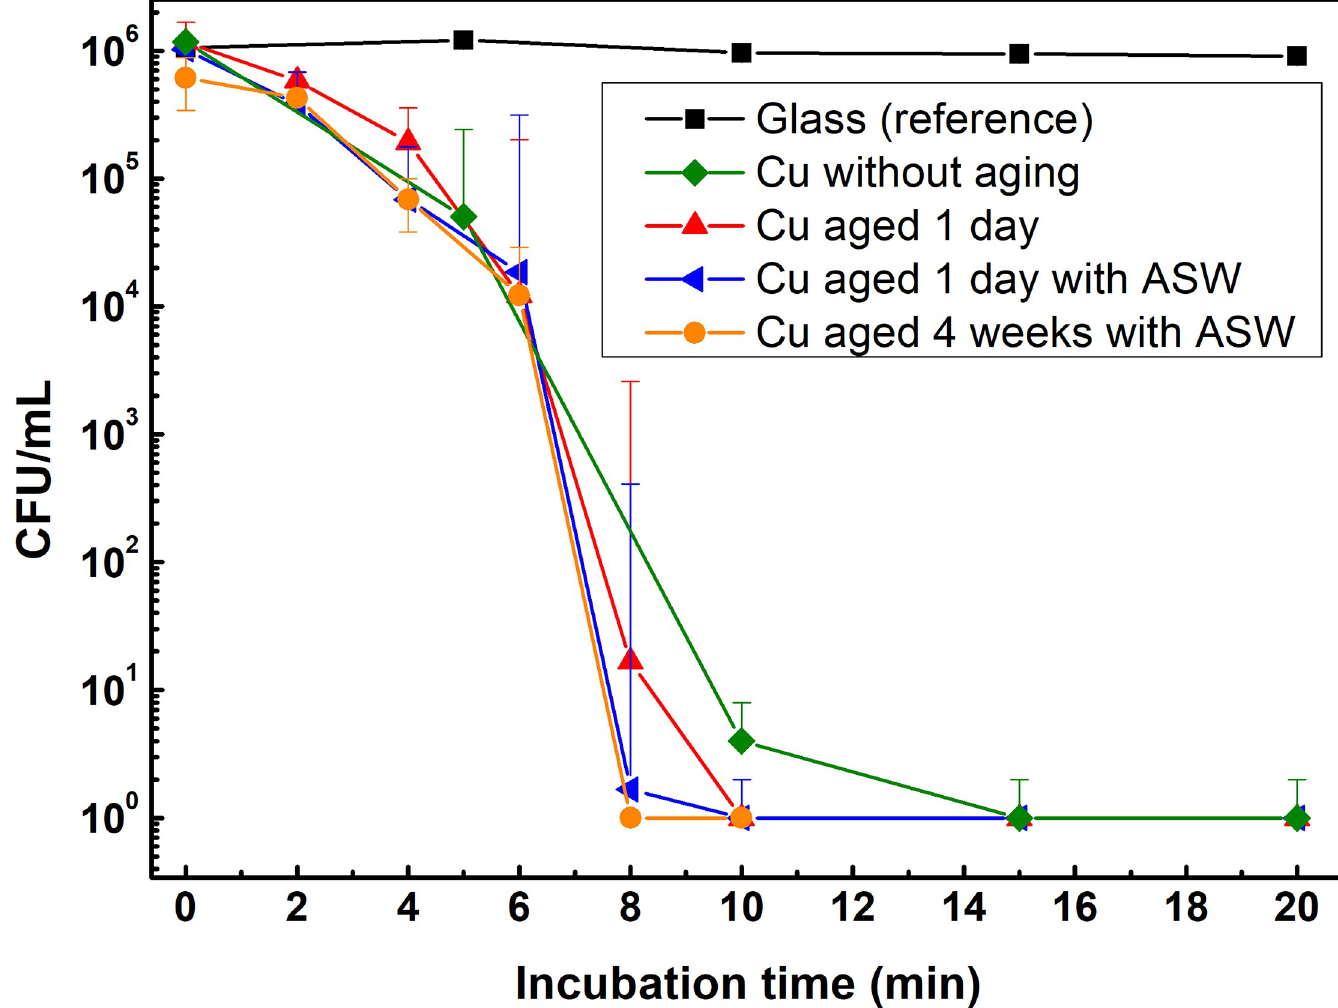
Fig 9. Kinetics in reduction of bacteria (E. coli) viability for one-day and 4 weeks tarnished/corroded Cu metal surfaces following the quasi-dry protocol up to 20 h of incubation at 37˚C. Each point is the average value of 6 NA plates including 2 replica from 3 different coupons and the statistic p-values were at all conditions < 0.05 (see detailed values in S2